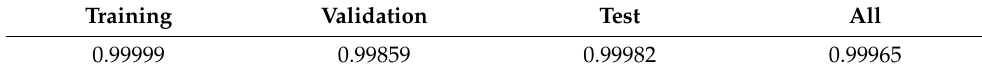
Table 5. The target values.